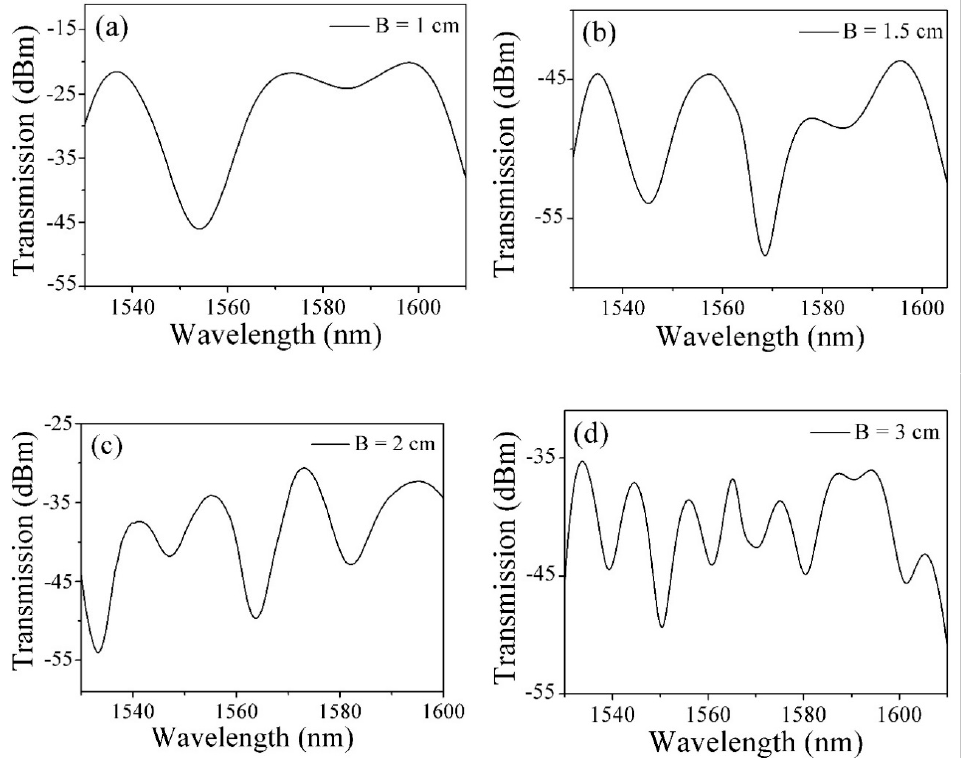
Figure 8. The transmission spectra of the proposed probe-type MZI with di ff erent B (interference length); ( a – d ) are 1, 1.5, 2, and 3 cm,